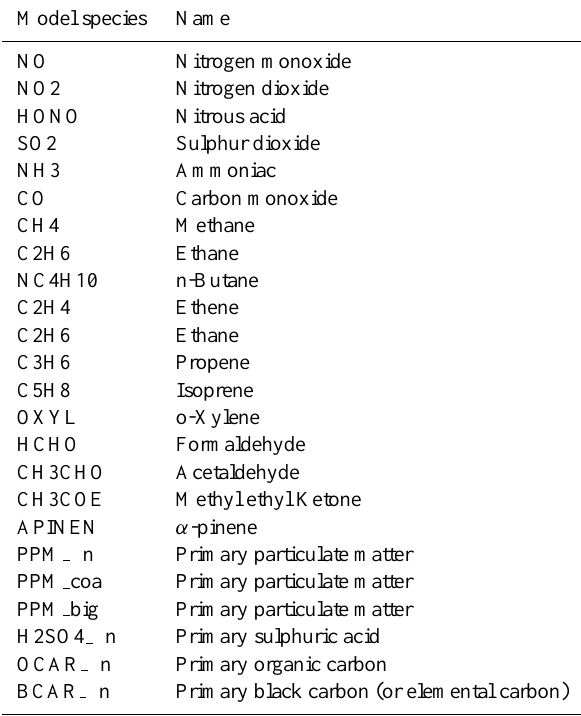
Table 3. List of MELCHIOR anthropogenic emitted